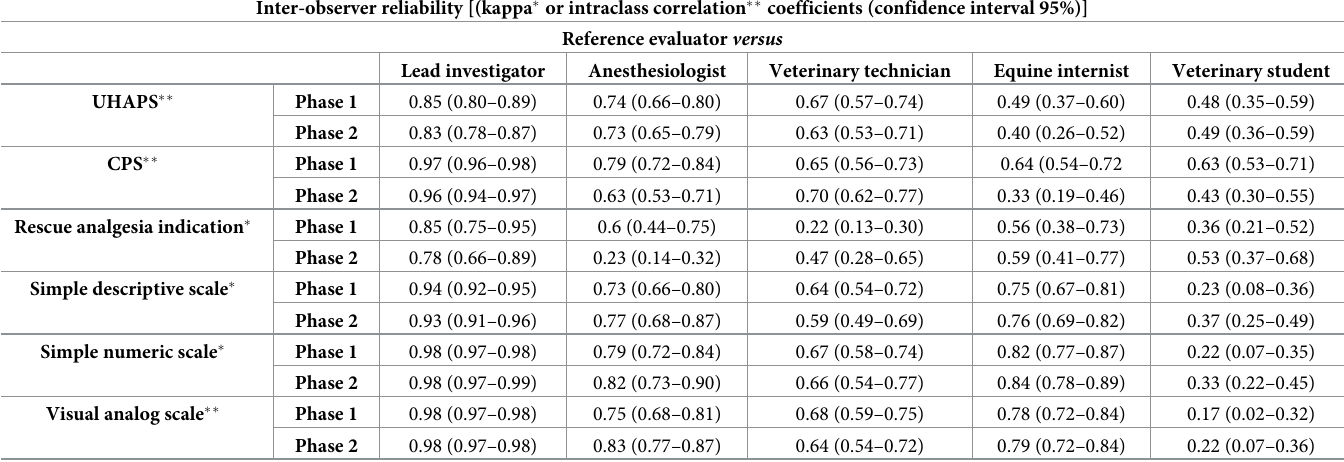
Table 4. Reproducibility of the Unesp-Botucatu horse acute pain scale (UHAPS), Composite Pain Scale (CPS), and unidimensional scales to assess perioperative pain in horses. Inter-observer reliability [(kappa � or intraclass correlation �� coefficients (confidence interval